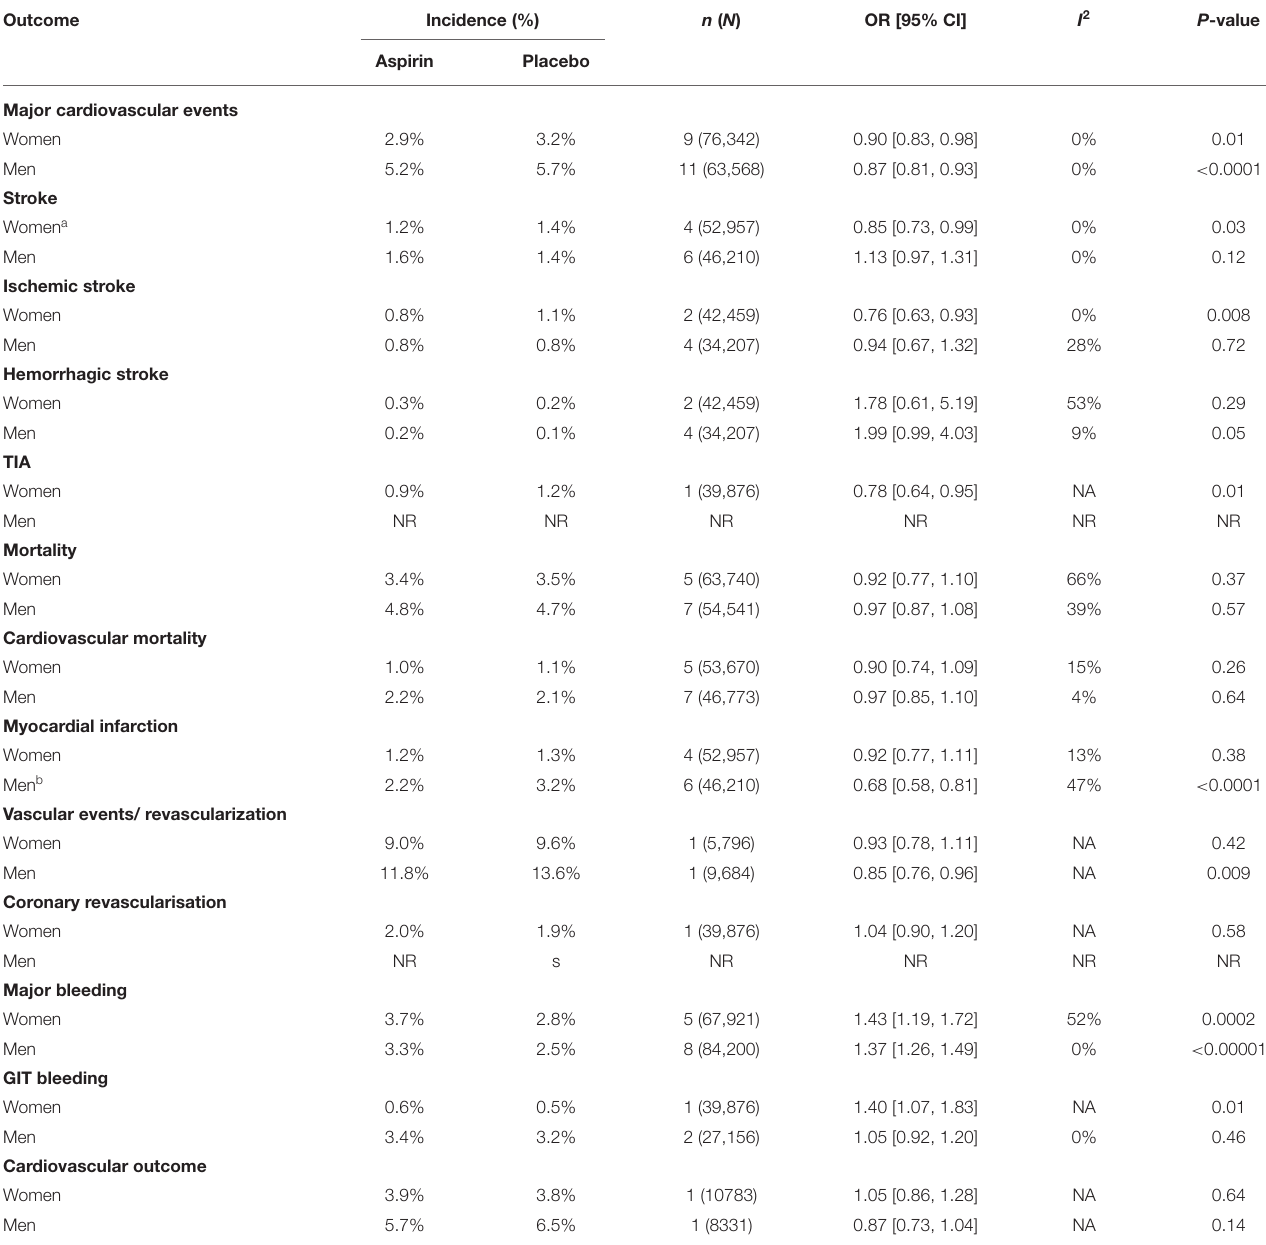
TABLE 2 | Role of aspirin in primary prevention of stroke, major cardiovascular events, mortality, myocardial infarction (MI), and bleeding in women and men. Outcome Incidence (%) n ( N ) OR [95% CI] I 2 P -value Aspirin